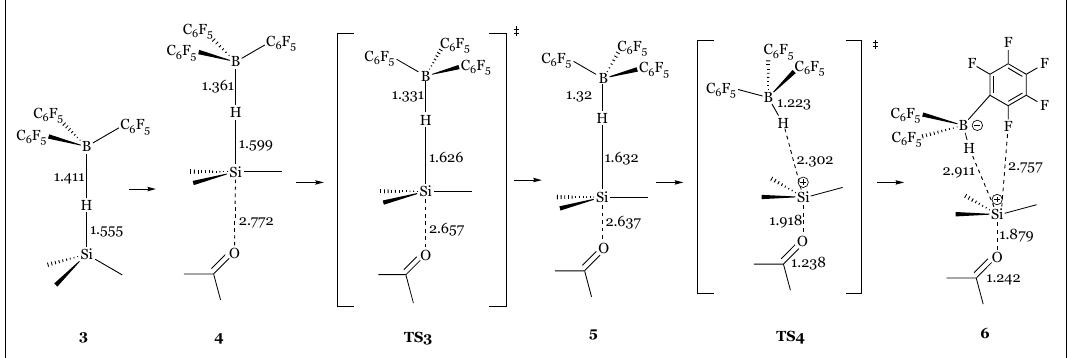
Figure 41. Intermediates and transition states of the silane-activation reduction mechanism.